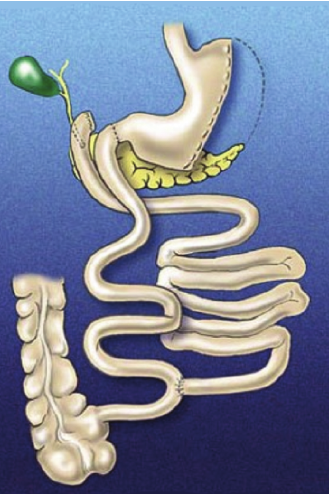
Figure 1: Illustration of the biliopancreatic diversion with duodenal switch